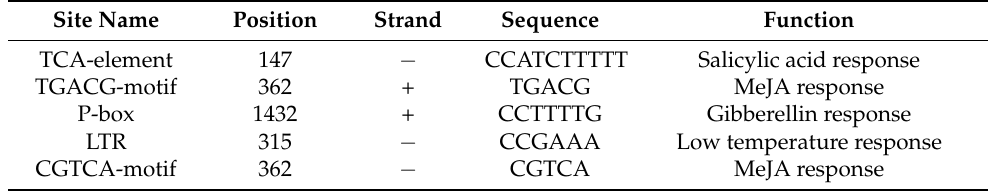
Table 1. Promoter analysis of